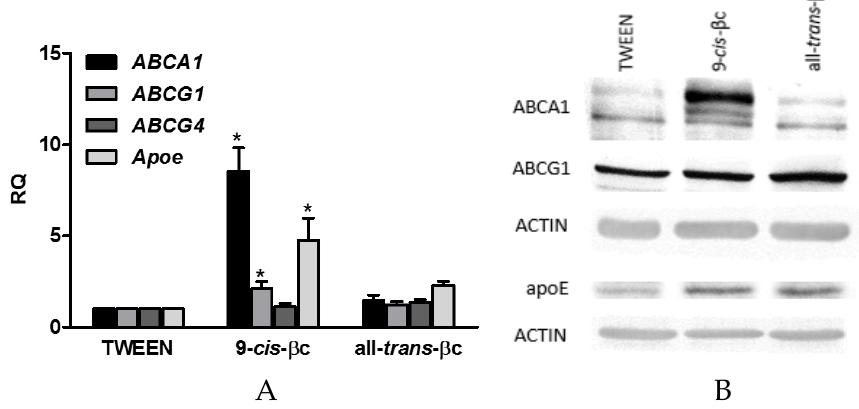
Figure 5. 9- cis - β c-induced mRNA and protein expression levels of genes involved in cholesterol efflux in macrophages. RAW264.7 macrophage cells were treated for 24 h with vehicle (TWEEN 40), 2 µM of 9- cis - β c or all- trans - β c. ( A ) The expression of ABCA1, ABCG1, ABCG4, and APOE mRNA were measured by quantitate real-time PCR assays (TaqMan) standardized against GAPDH mRNA levels. The results are expressed as mean ˘ SE. of six independent experiments. * p < 0.05; ( B ) ABCA1, ABCG1, and APOE protein levels were determined by Western blot analysis. The results represent one of five independent